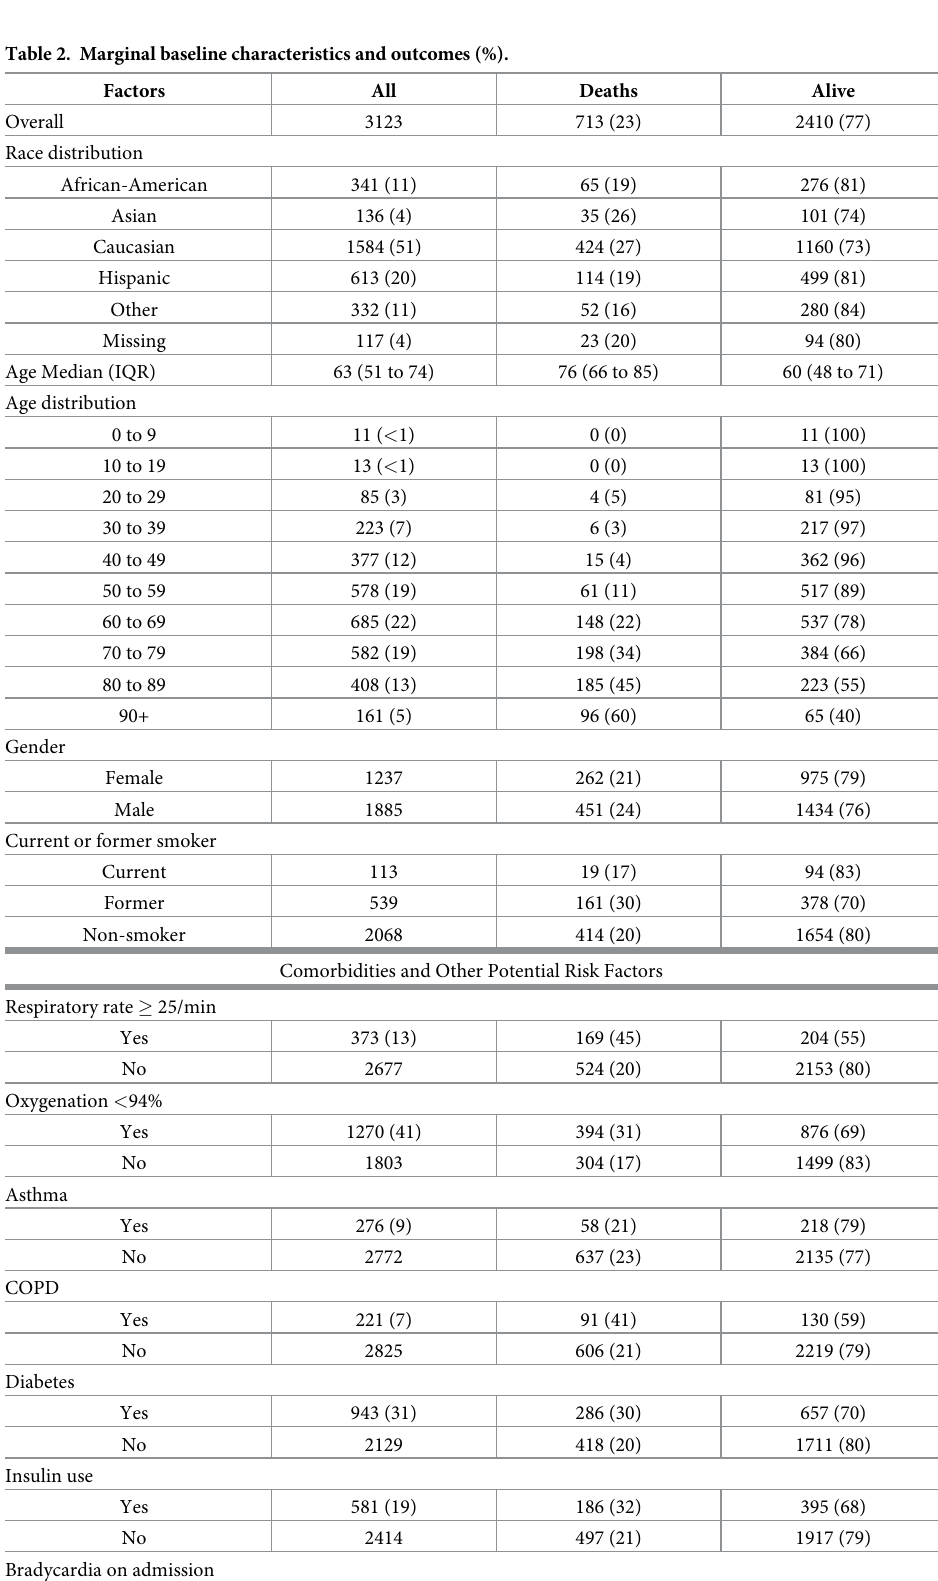
Table 2. Marginal baseline characteristics and outcomes